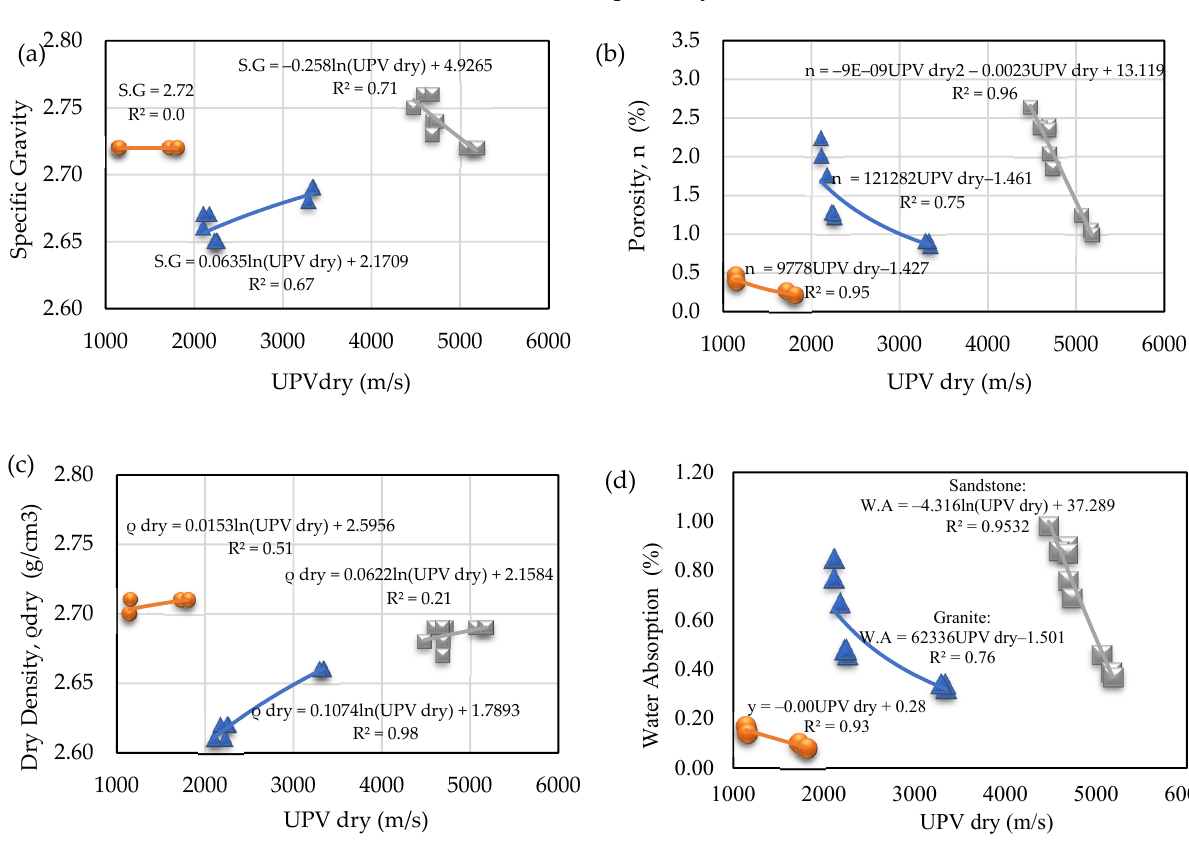
Figure 6. Correlation of UPV dry against ( a ) specific gravity, ( b ) porosity, ( c ), dry density and ( d ) water absorption for granite, marble, and sandstone. Granite —- Marble —- Sandstone